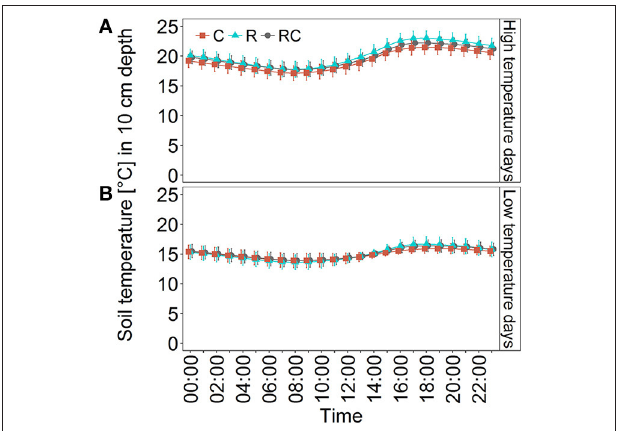
FIGURE 6 | Soil temperature ( ◦ C) as measured in 10cm depth using iButton temperature loggers under the rainout-shelter (R), the rainout-shelter control treatment (RC), and the ambient control plots (C). Data points represent hourly temperature measurements (means ± standard deviation) of two plots and 3 days during (A) a high temperature phase (June 18–20, 2017) and (B) a low temperature phase (June 6–8,